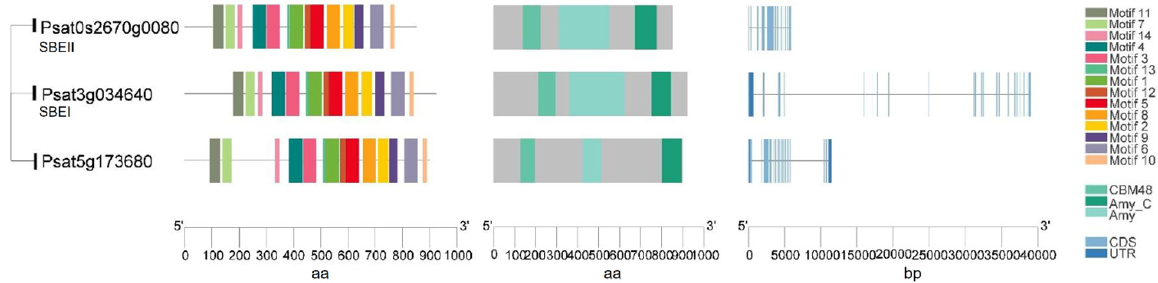
Figure 4. Gene structure, functional domains and conserved motifs in putative starch branching enzyme (SBE) isoforms in pea. Domains identified are the carbohydrate-binding module family 48 (CBM48) domain, α -amylase (Amy) domain and α -amylase C-terminal (Amy_C) domain.